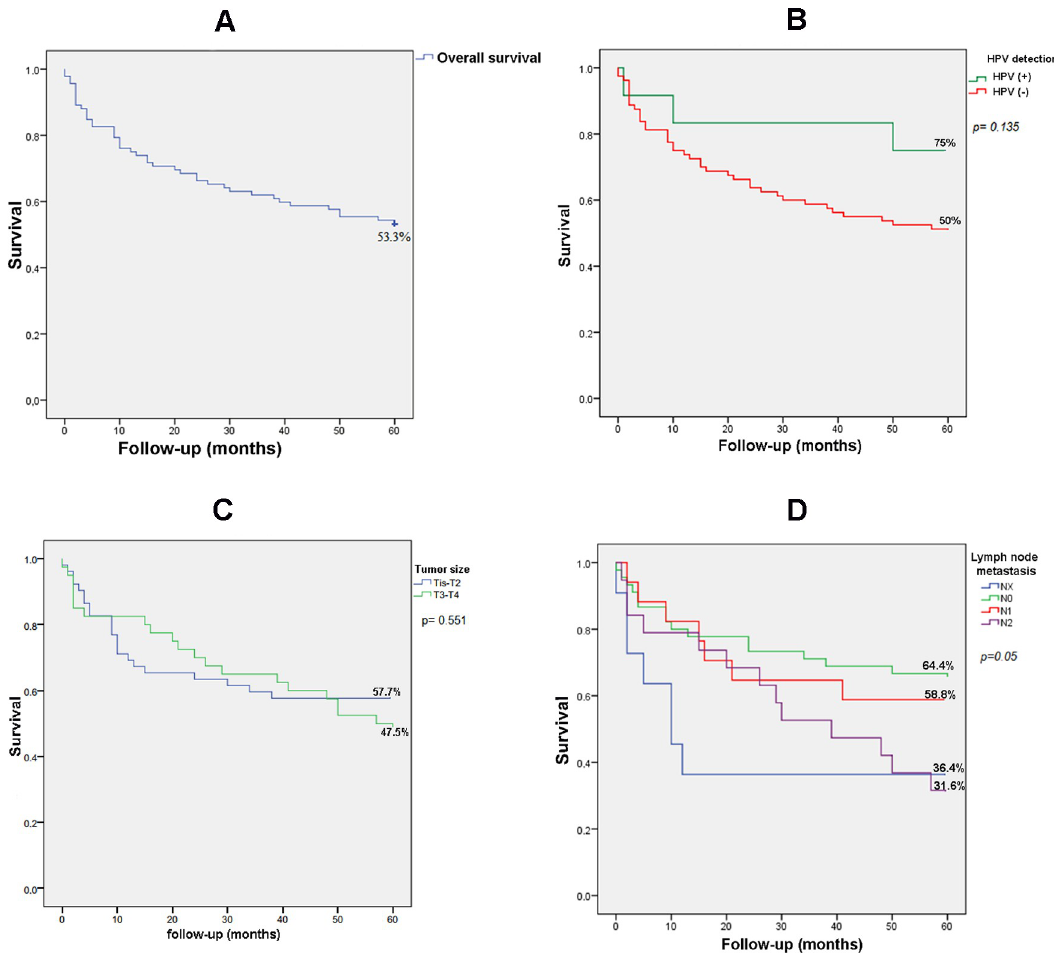
Fig 3. The survival analysis. A. Overall 60-month survival for participants with colorectal cancer (Kaplan-Meier method). B. 60-month survival for participants with colorectal cancer in relation to the presence or absence of HPV DNA (Kaplan-Meier method). C. 60-month survival for participants with colorectal cancer in relation to tumor origin (Kaplan-Meier method). D. 60-month survival for participants with colorectal cancer in relation to p16 INK4a expression (Kaplan-Meier